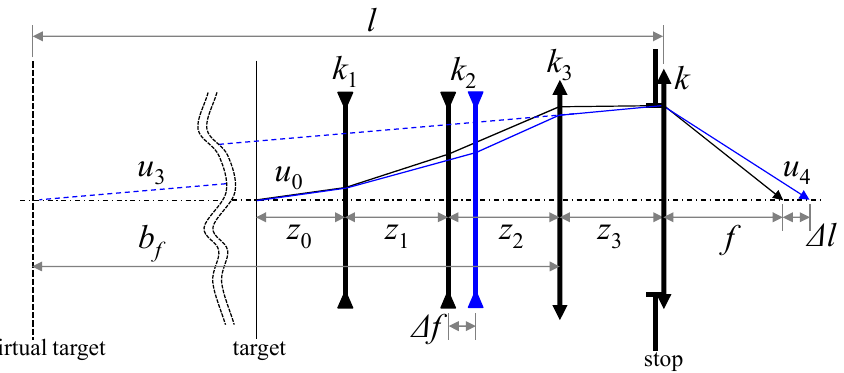
Figure 2. Paraxial layout of our proposed focus-adjustable collimator.